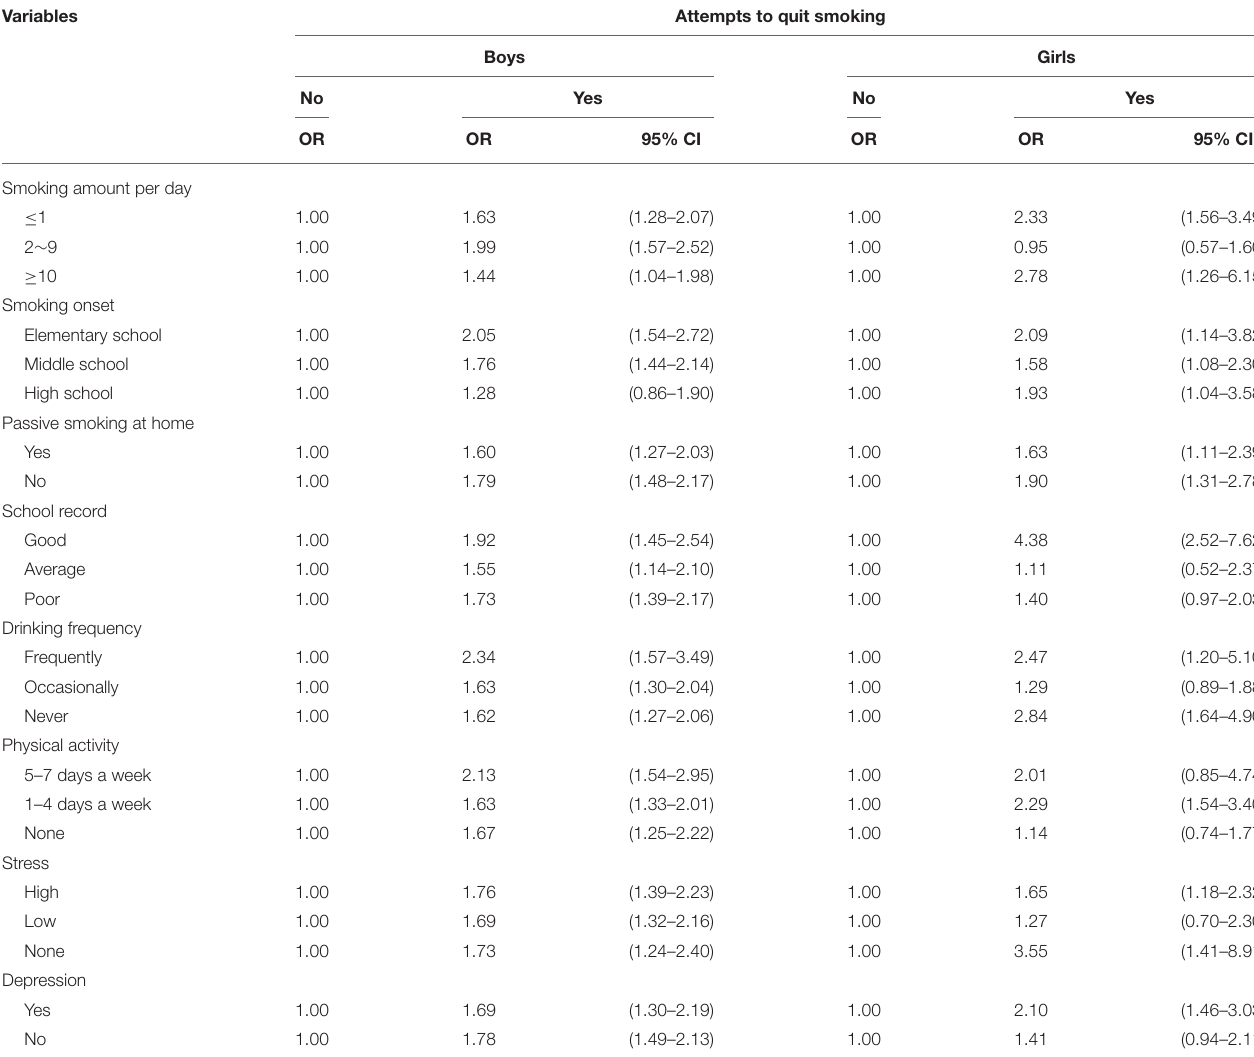
TABLE 4 | Results of subgroup analysis for the association between GHWL and attempts to quit smoking.